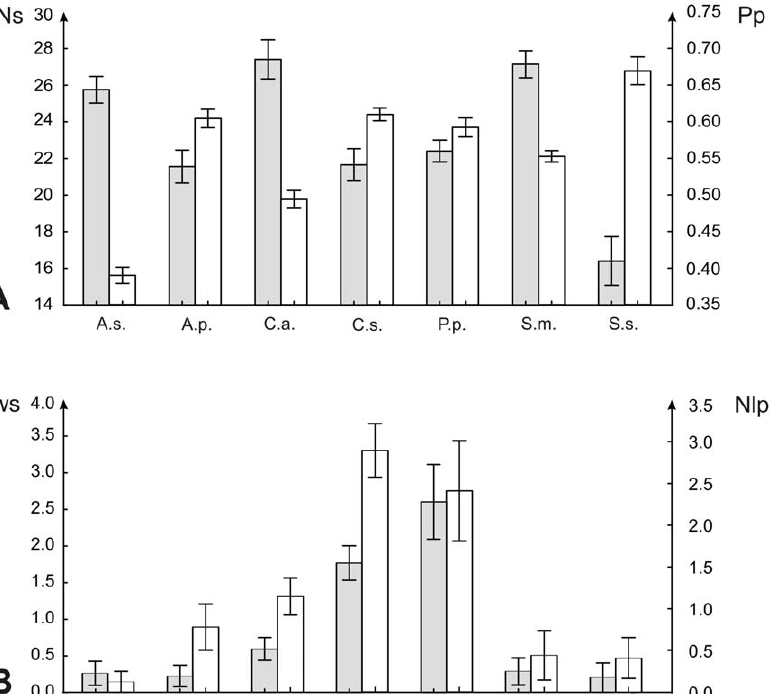
Figure 1. Mean and standard error of the mean for different microwear variables. A, number of scratches (Ns) and pit percentage (Pp); B, number of wide scratches (Nws) and of large pits (Nlp). Abbreviations for taxa are as follows: A.s. Alouatta seniculus ; A.p. Ateles paniscus ; C.a. Cebus apella ; C.s Chiropotes satanas ; Pp. Pithecia Pithecia ; S.m. Saguinus midas ; S.s. Saimiri sciureus . doi:10.1371/journal.pone.0027392.g001 PLoS ONE |